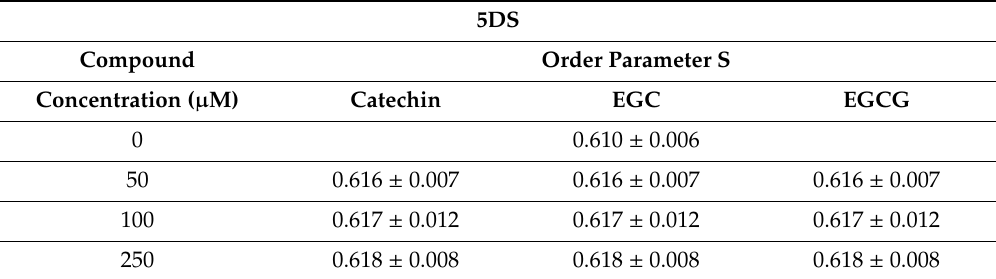
Table 3. E ff ect of catechins on the order parameter of 5-doxyl stearic acid (5DS) and 16-doxyl-stearic acid (16DS) in erythrocyte membranes. Mean values ± SD, n ≥